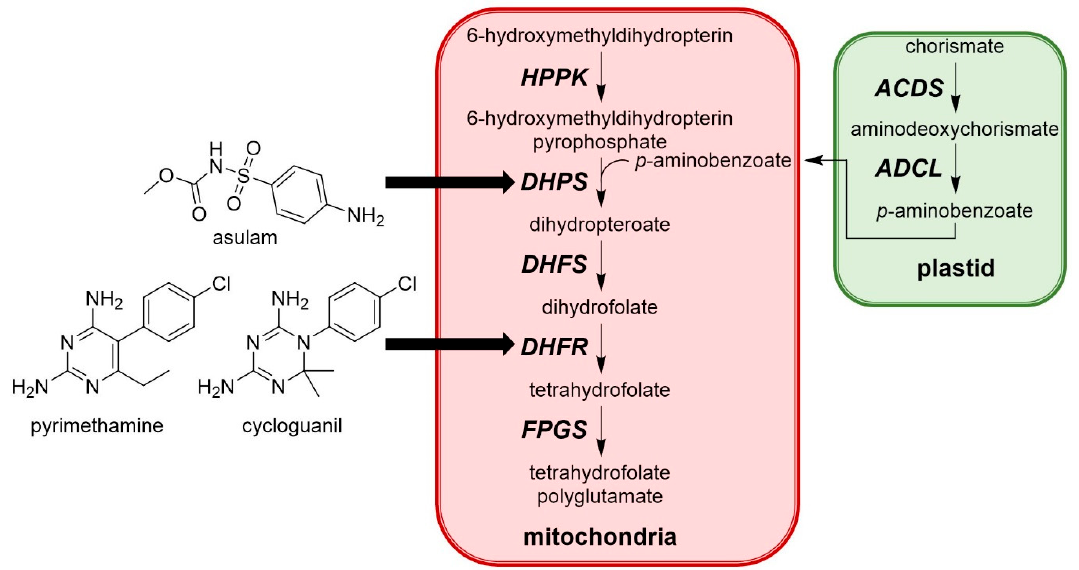
Figure 13. Simplified biosynthesis of folate in higher plants and structures of herbicidal compounds targeting this pathway. HPPK: 6-hydroxymethyldihydropterin pyrophosphokinase; DHPS: dihydropteroate synthase; DHFS: dihydrofolate synthetase; DHFR: dihydrofolate reductase; FPGS: folylpolyglutamatesynthetase; ADCS:aminodeoxychorismatesynthase; ADCL:aminodeoxychorismate